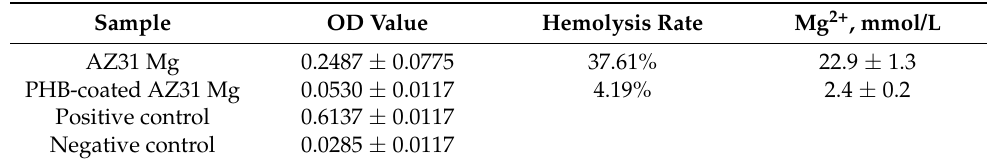
Table 4. Detailed data of hemolysis rate